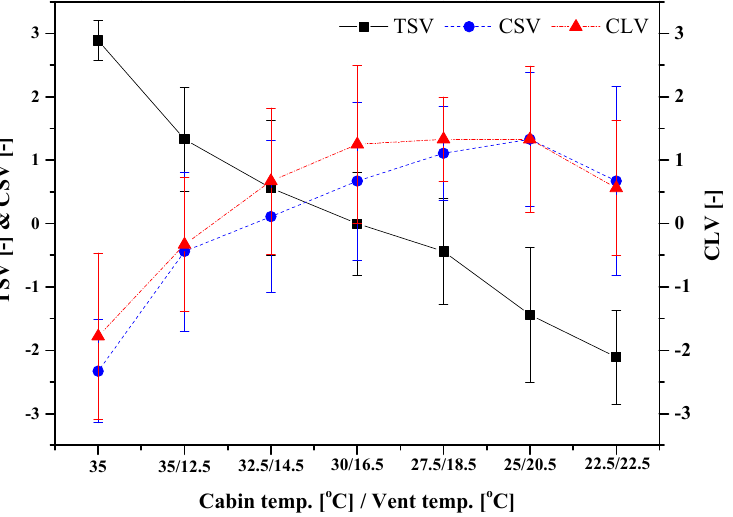
Figure 8. Variations of TSV, CSV, and CLV